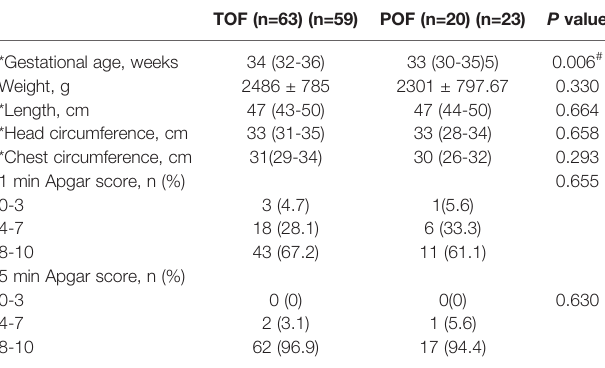
TABLE 3 | Comparison of living neonates between POF and TOF groups.